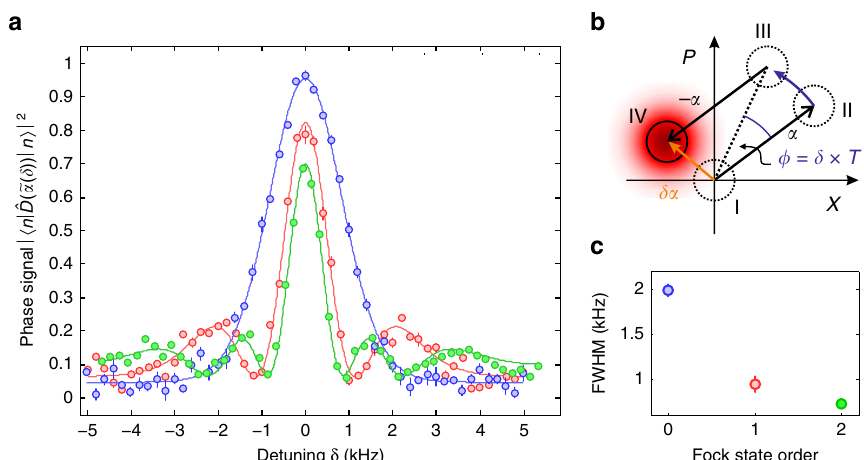
Fig. 3 Trapping frequency measurement. a Center fringe of the Ramsey pattern for three different initial Fock states (blue: n = 0, red: n = 1, green: n = 2). The circles show the experimental data, which is the population probability of the ion in the #j i -state ( "j i for n = 0, see text for details). The solid lines show a fi t of the theoretically expected lineshape to the data (see Supplementary Note 3). b shows a sketch of the phase-space trajectory during the sequence (see text for details). It is assumed that t F (cid:5) 1 = δ , otherwise the phase space trajectories would be curved. c shows the full-width-half-maximum (FWHM) extracted from a Gaussian fi t to the data. Each data point consists of 1000 experimental cycles, evaluated with a distribution fi t technique 19 slope of the signal from Fig. 1e. Note that for white noise,